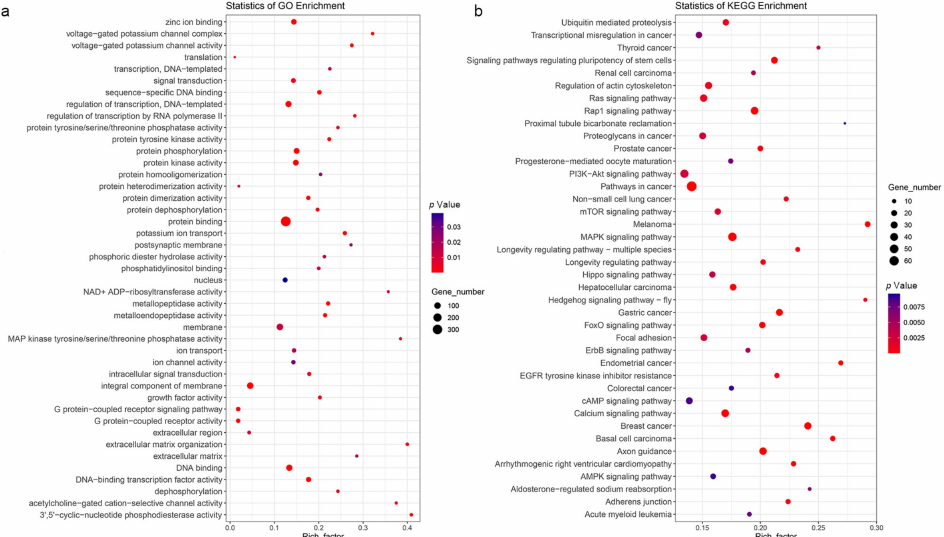
Figure 5. GO term and KEGG pathway enrichment analysis of rapidly evolving genes. The size of the circle in each GO term and pathway of each species represents the number of genes. The color of each circle represents the p -value of this term or pathway, and the redder the color, the smaller the p -value. ( a ) GO term enrichment analysis of rapidly evolving genes. ( b ) KEGG pathway enrichment analysis of rapidly evolving genes.